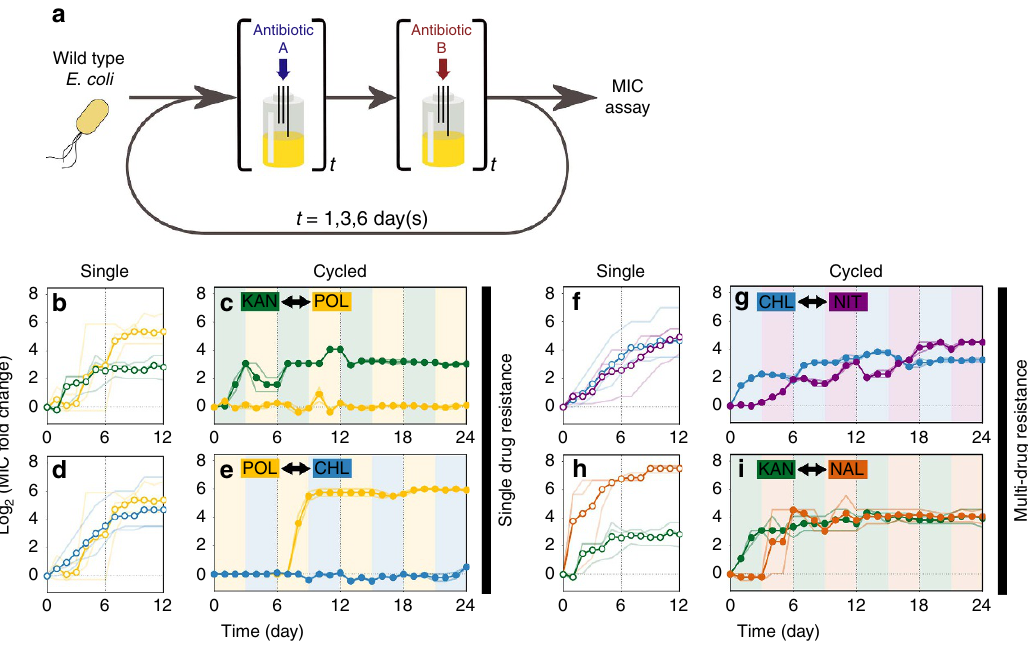
Figure 1 | Evolution of antibiotic resistance under antibiotic cycling condition. ( a ) Experimental design for bacterial evolution under cyclic exposure to two antibiotics. Wild-type E. coli was cultured in the morbidostat system with dynamic antibiotic concentrations. The Every t days (where t ¼ 1, 3 and 6), the drugs were switched in an alternating manner and the cell cultures were sampled daily and stored at (cid:2) 80 (cid:2) C. After a total of 12 or 24 days the MICs of the collected samples were determined. ( b ) Evolutionary trajectories of KAN and POL resistance (green and yellow curves, respectively) under single antibiotic condition. Trajectories of parallel experiments were shown as pale lines and the average of parallel experiments was in solid line with empty circles. The resistance levels were measured as MIC fold change relative to the wild-type, calculated by log 2 (MIC i /MIC WT ), where MIC i and MIC WT are the MICs of the i -th day sample and wild-type E. coli , respectively. ( c ) Trajectories of KAN and POL resistance when cycled with 3 day interval. Pale lines indicate trajectories of parallel experiments and the average was shown as solid line with filled circles. The pale coloured background indicates the antibiotics used. ( d , e ) evolutionary trajectories of CHL and POL resistance (blue and yellow) under single antibiotic condition and cycling with 3 day interval, respectively. Similarly, for ( f , g ) CHL and NITresistance (blue and purple), and ( h ) and ( i ) KAN and NAL resistance (green and orange). Samples sizes are n ¼ 3 for single antibiotic condition and n ¼ 2 for antibiotic cycling (biological